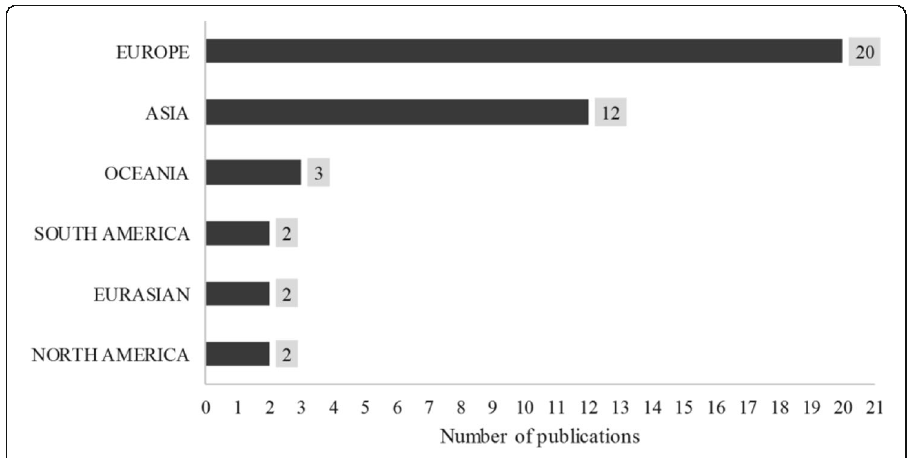
Fig. 6 Number of papers in the corpus published by